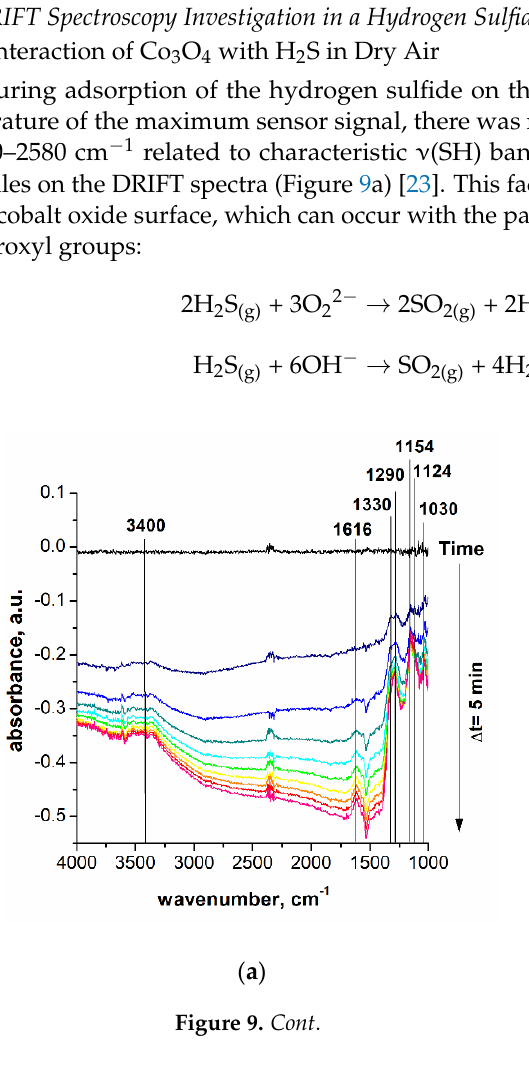
Figure 8. The sensor signal toward 1 ppm H 2 S, 20 ppm NH 3 , 20 ppm CO (divided by gas concentration) of Co 3 O 4 and Ni x Co 3 − x O 4 at 210 °C ( a ) 0% R.H. ( b ) 30% R.H.